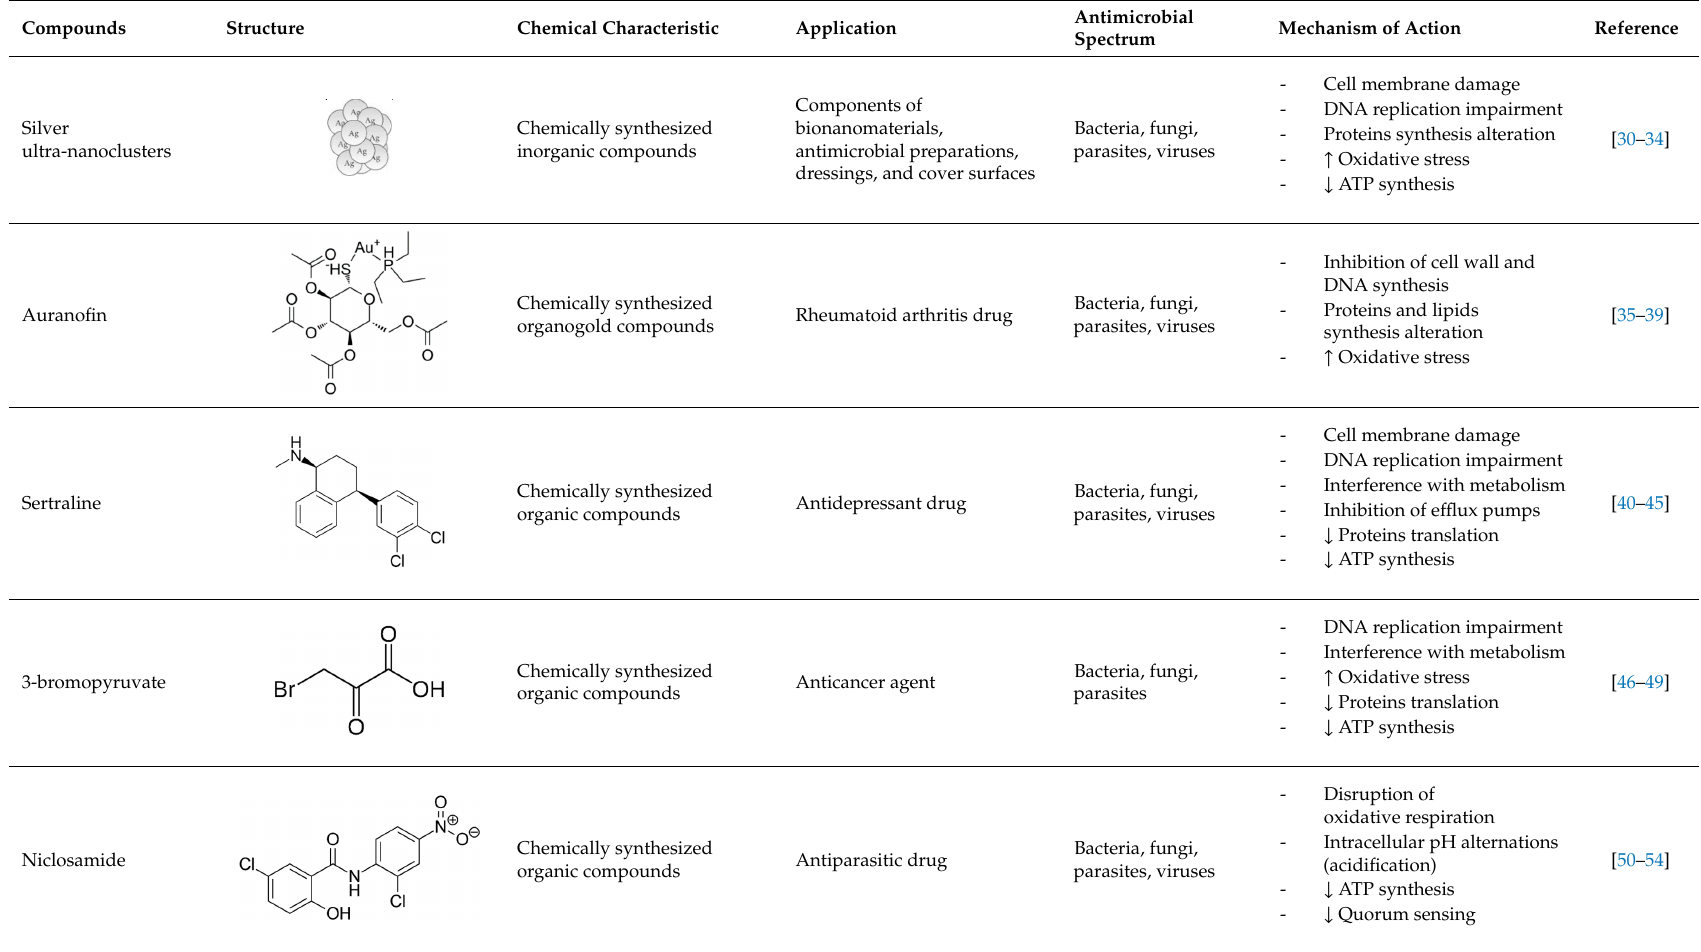
Table 1. Characterization of non-antibiotic compounds showing a positive antibacterial interaction with classically used antibiotics against H. pylori .